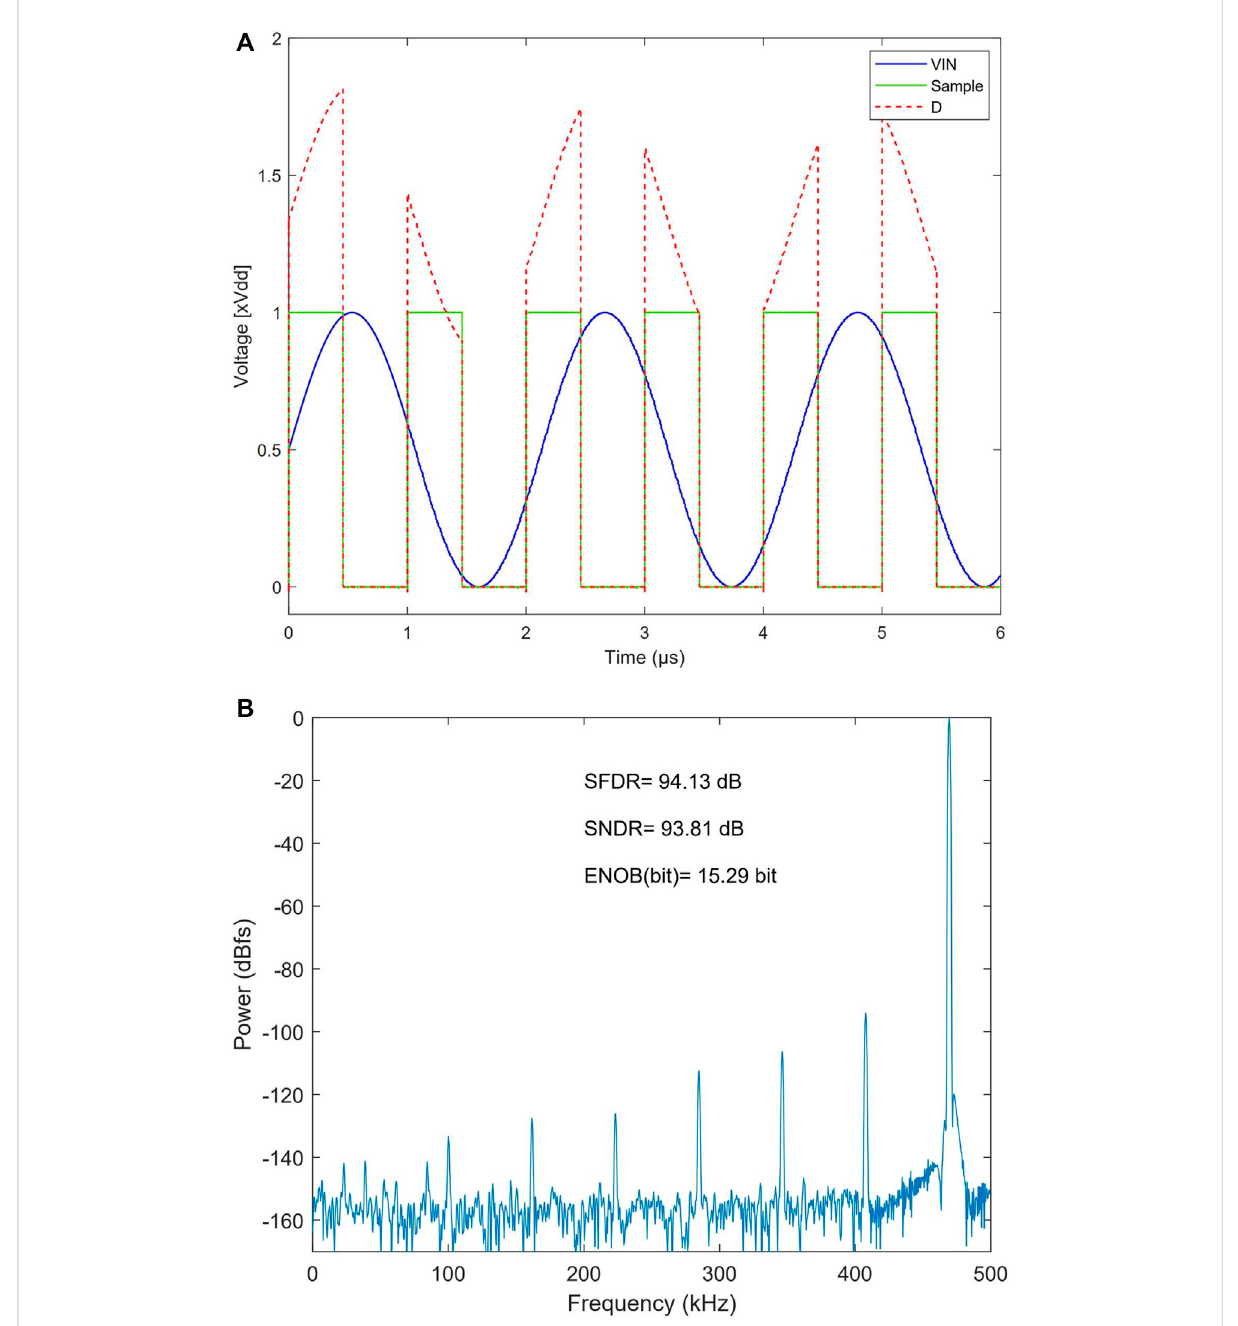
FIGURE 11 Simulation of bootstrapped sampling switch. (A) Transient simulation. (B) FFT of Bootstrapped sampling